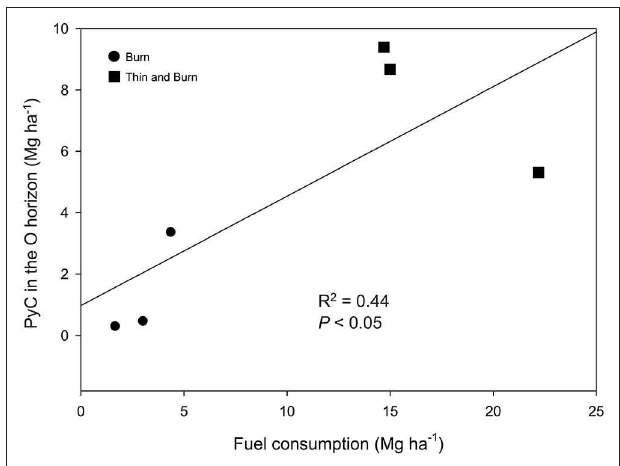
FIGURE 3 | Correlation ( R 2 and P -value) between PyC in the O horizon (Mg ha − 1 ) and the amount of fuel consumed (Mg ha − 1 ) in “burn” and “thin&burn” treatments in the Fire and Fire Surrogates study in Western Montana,